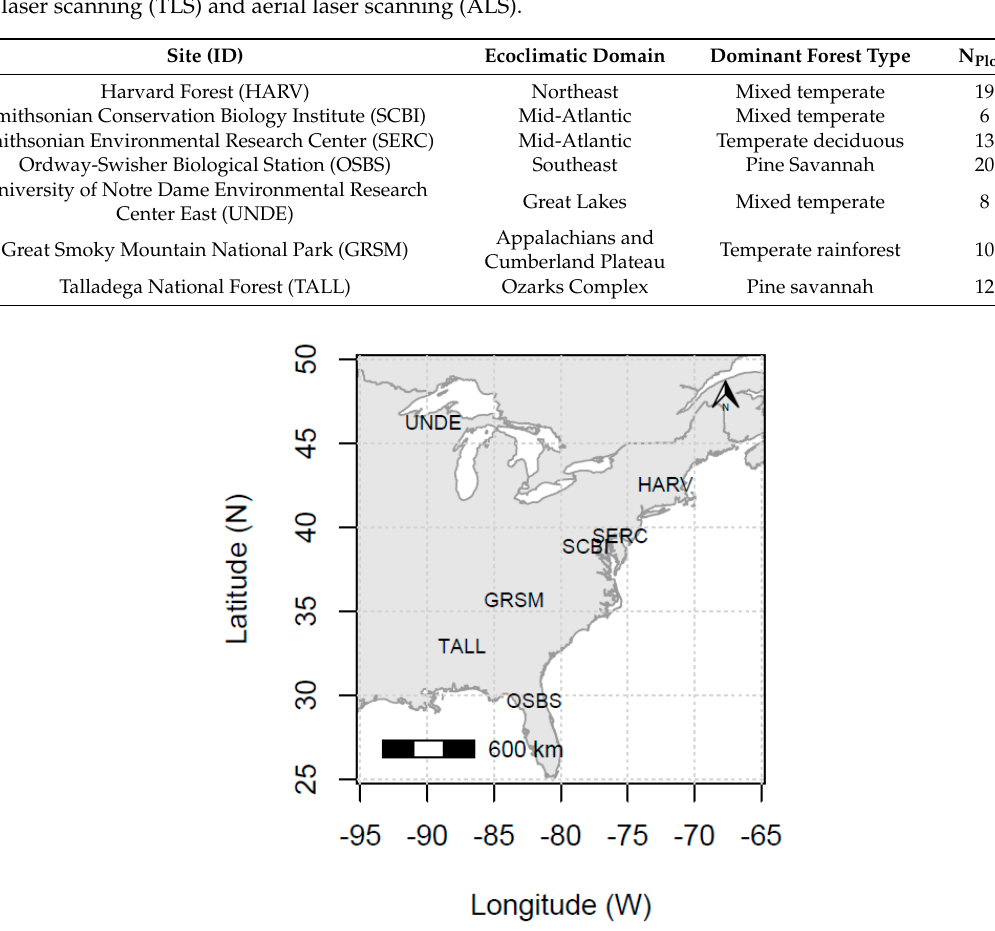
Figure 2. Seven forested sites (see Table 1 for site descriptions) from the National Ecological Observatory Network across the eastern USA measured by aerial laser scanning (ALS) and terrestrial laser scanning (TLS).